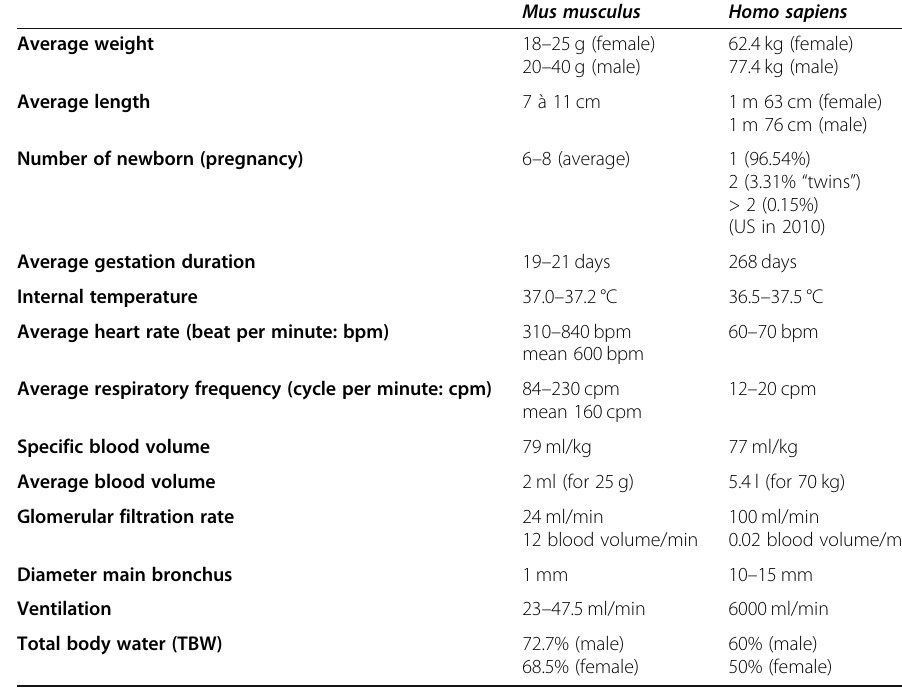
Table 1 Average anatomical and physiological data of adult mice compared to